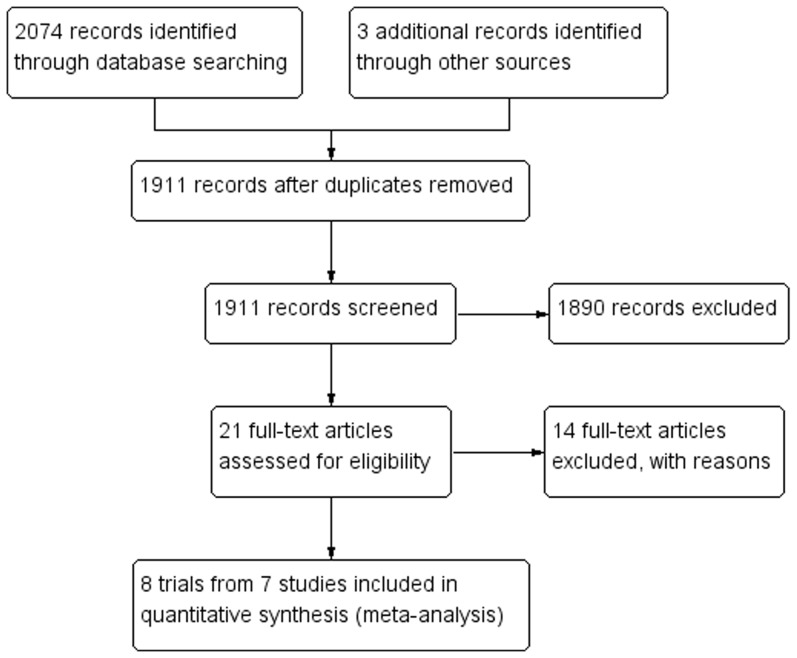
Study flow diagram.